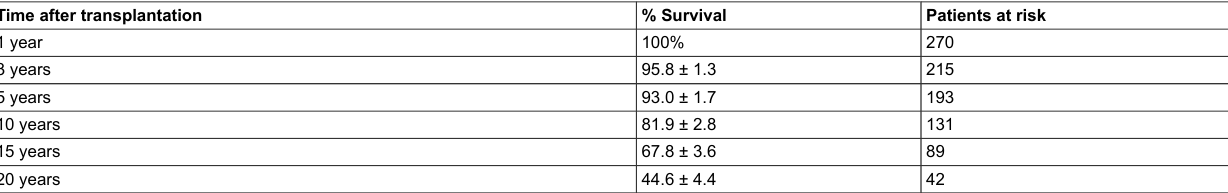
Data are expressed as % ± standard deviation Table S2: Pretransplantation laboratory values.